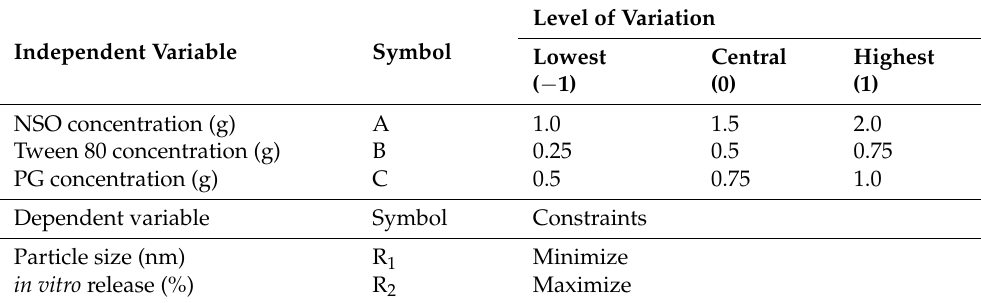
Table 1. Factorial design independent variables with their level of variation and the examined dependent